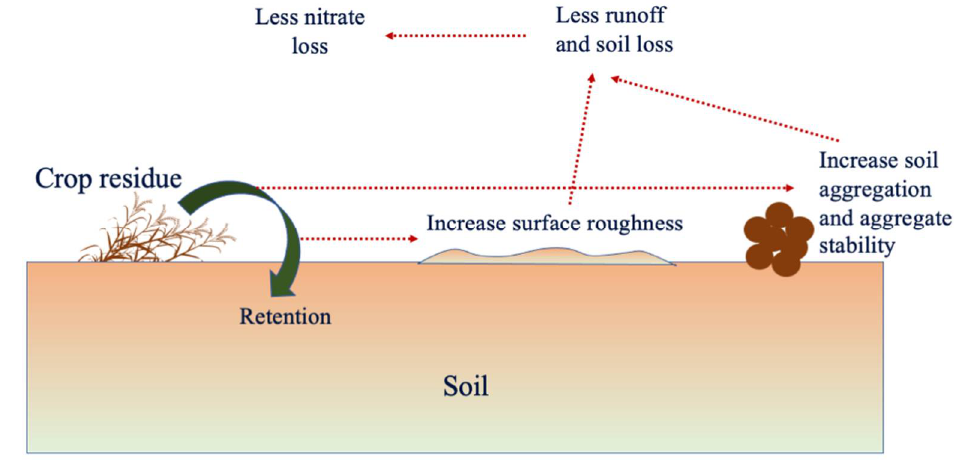
Figure 4. Effect of conservation agriculture on water erosion. Table 2. Comparison of conservation agriculture (CA) and conventional tillage (CT) on soil loss (t/ha).